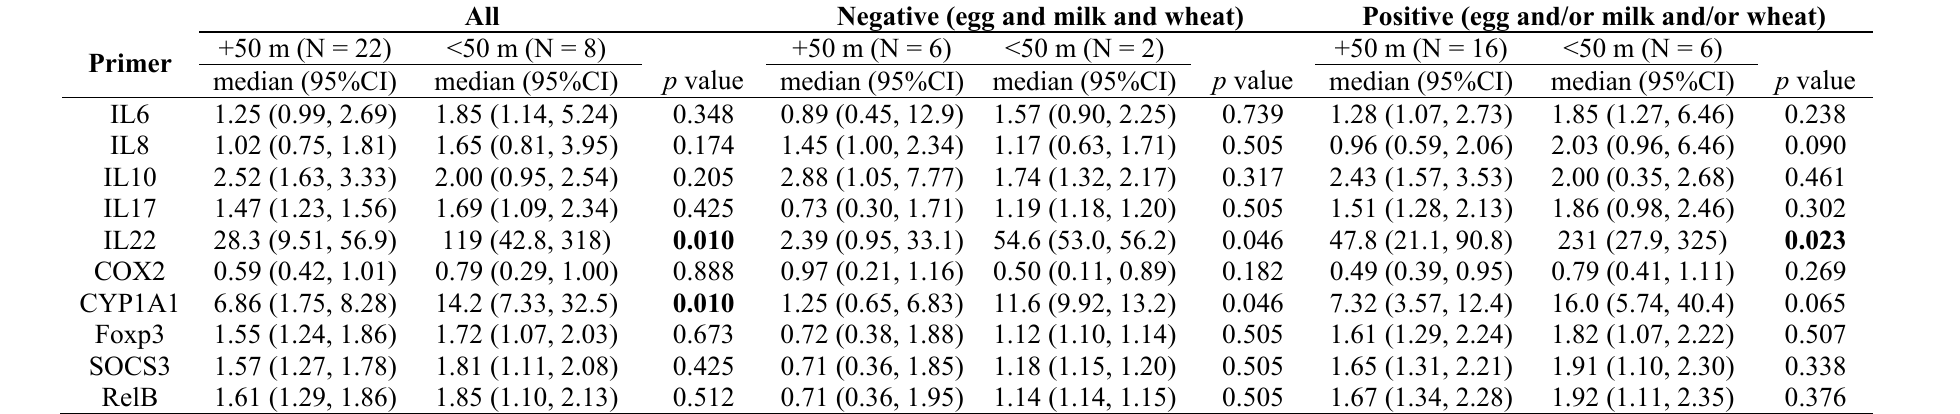
Table 1. Relationship between the expression of select biomarkers and the distance from the home to large roads among all study subjects as well as among two sub-groups separated according to food-specific IgE status.